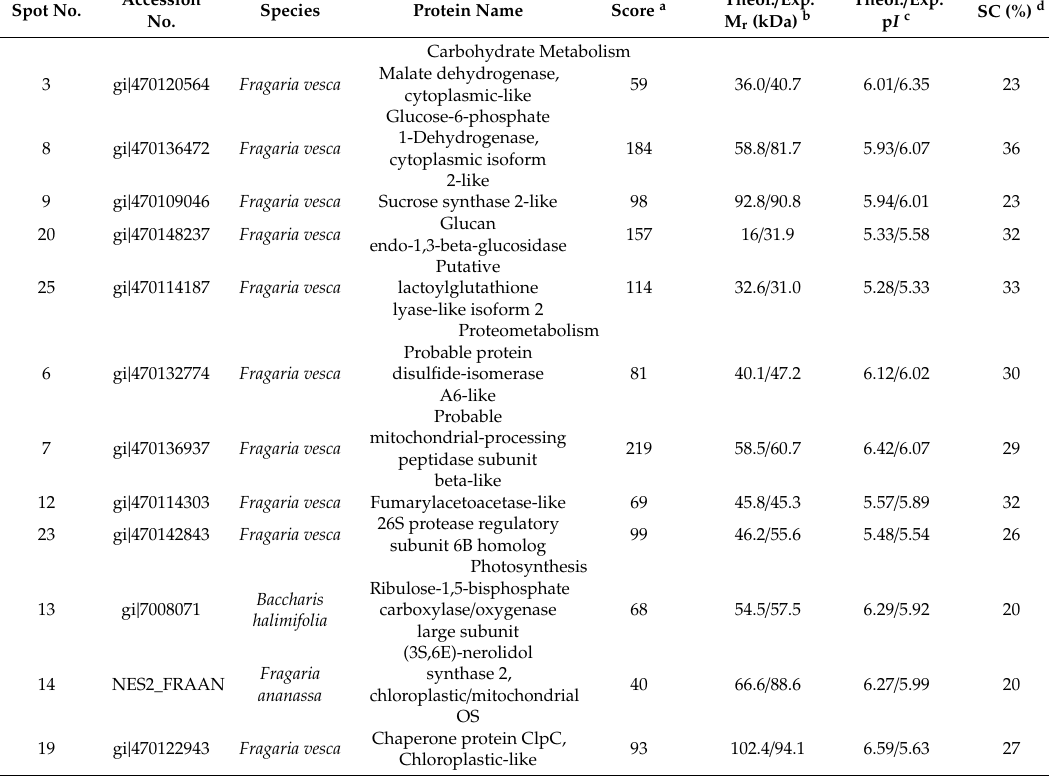
Figure 5. The expression profiles of 32 DEPs under LD and SD conditions. LD1, LD2, LD3, SD1, SD2, and SD3 represent the three replicates in each treatment. The significant differences were calculated by Student’s t -test. Table 2. Proteins identified by the MALDI-TOF MS in strawberry. Spot